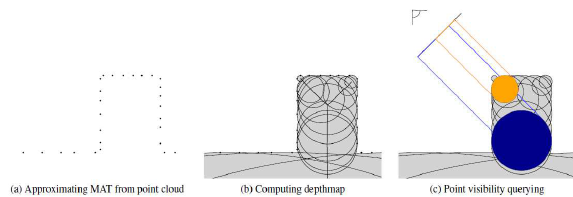
Figure 4. MAT approach to visibility analysis in three steps (Peters et al., 2015)